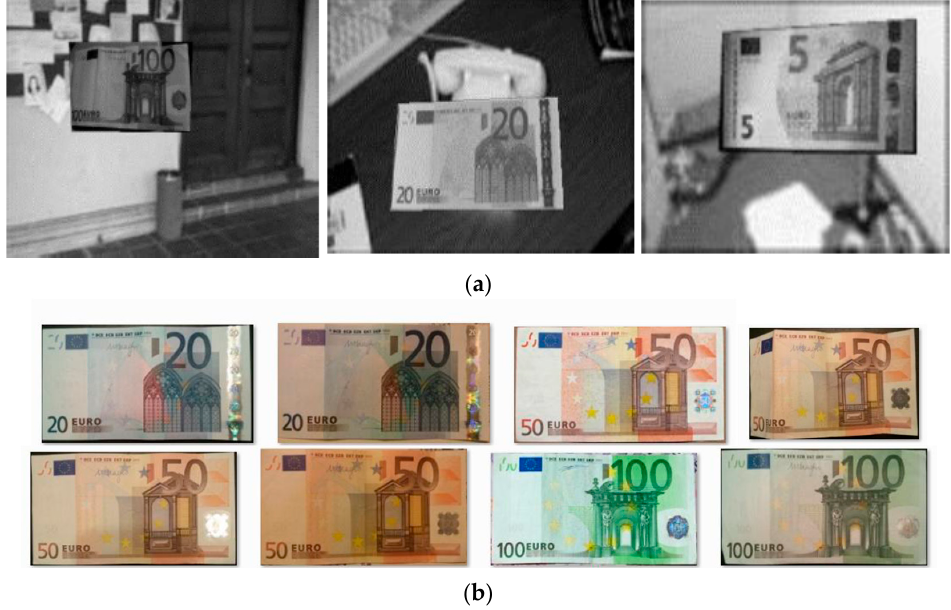
Figure 5. Training samples: Samples of real Euro banknotes and banknotes with background exposed.